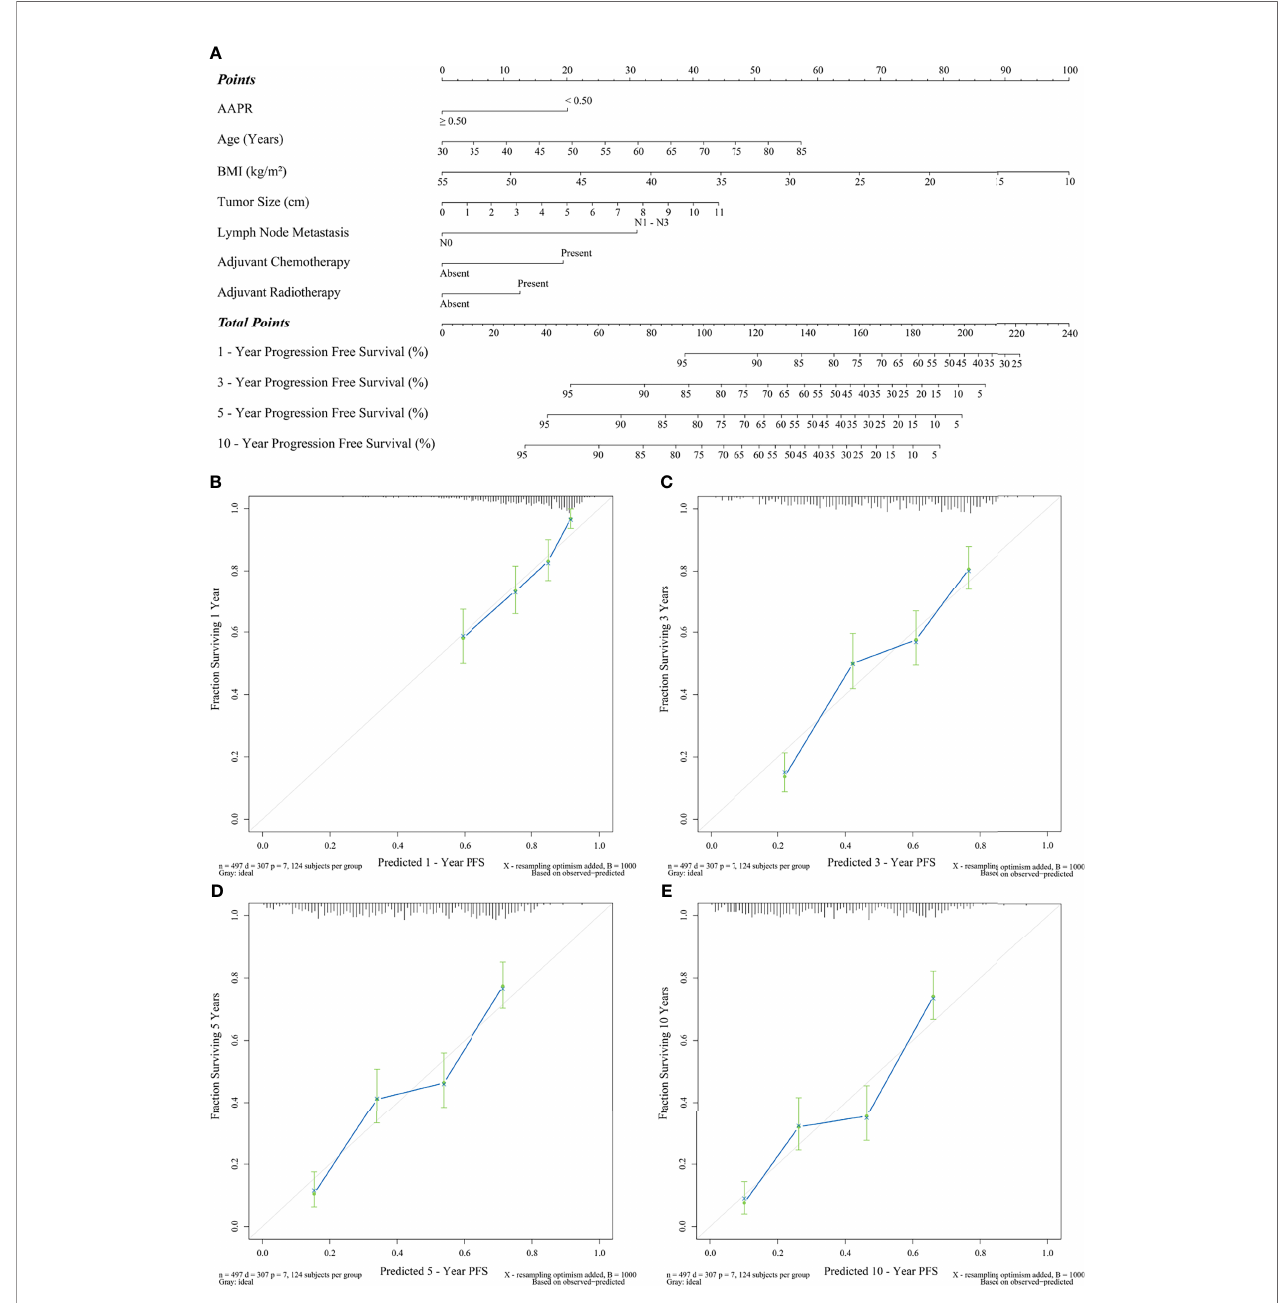
FIGURE 6 | Prediction of PFS by preoperative AAPR. (A) AAPR composite nomogram and its calibration curves (B) 1-year PFS, (C) 3-year PFS, (D) 5-year PFS, and (E) 10-year